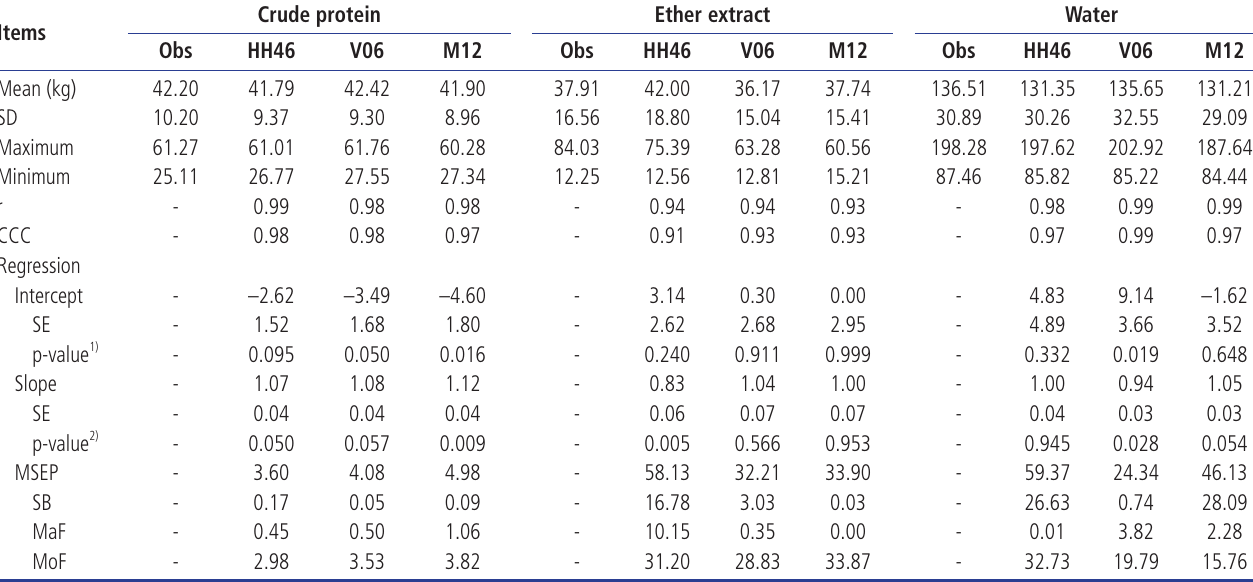
Table 5. Descriptive statistics of the relationships between the observed and predicted carcass chemical composition values Crude protein Ether extract Water Items